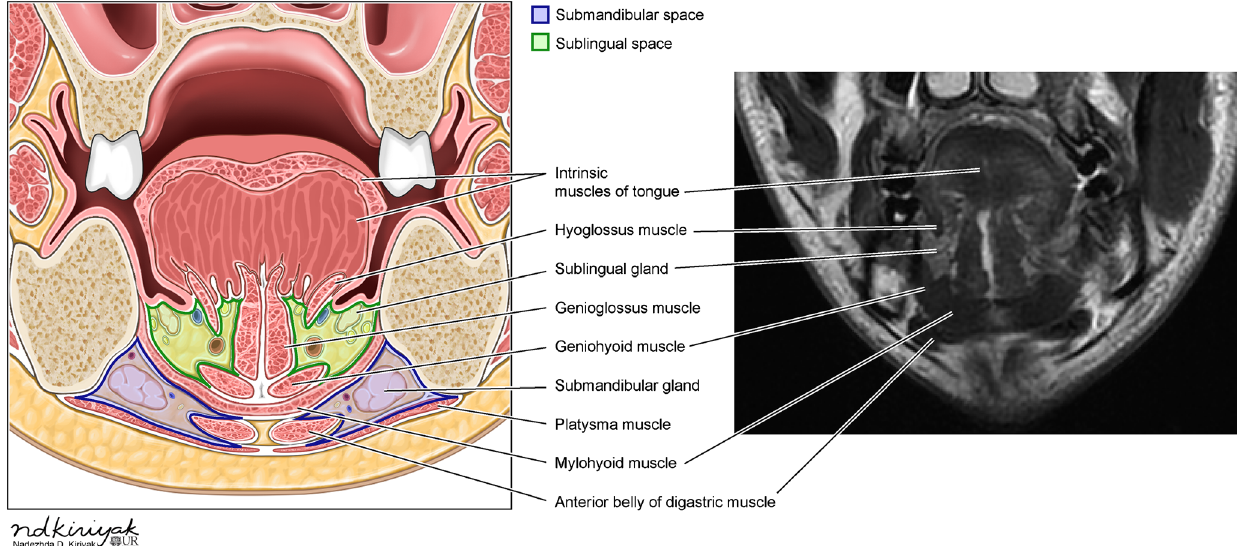
Fig. 2 Anatomy of the submandibular and sublingual spaces in the coronal plane: picture illustration and T2-weighted MR image